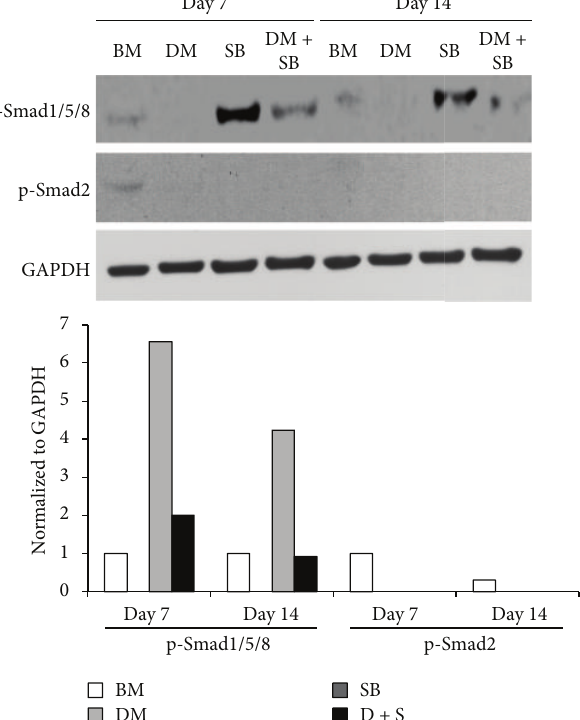
Figure 5: Dual inhibition of activin/nodal/TGF- 𝛽 and BMP signal- ing pathways by DM and SB inhibits activation of Smad proteins in hADSCs. hADSCs were grown in BM or BM supplemented with either activin/nodal/TGF- 𝛽 pathway inhibitor SB or BMP pathway inhibitor DM or both for 7 and 14 days. The cells were harvested after 7 and 14 days and total proteins were harvested using extraction reagent. Procedure was followed as mentioned in Figure